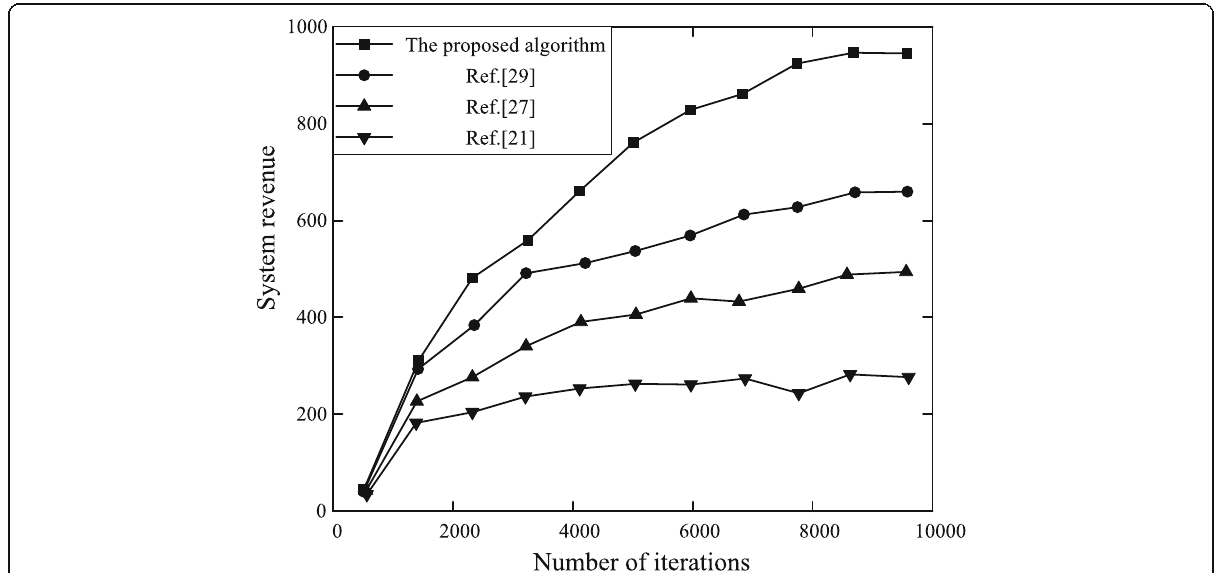
Fig. 9 Comparison for the revenue results of different